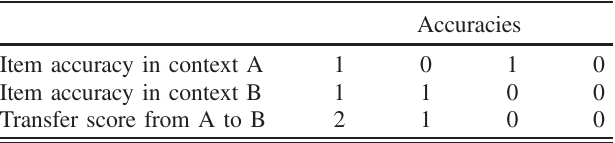
TABLE VII. Allocation of transfer score